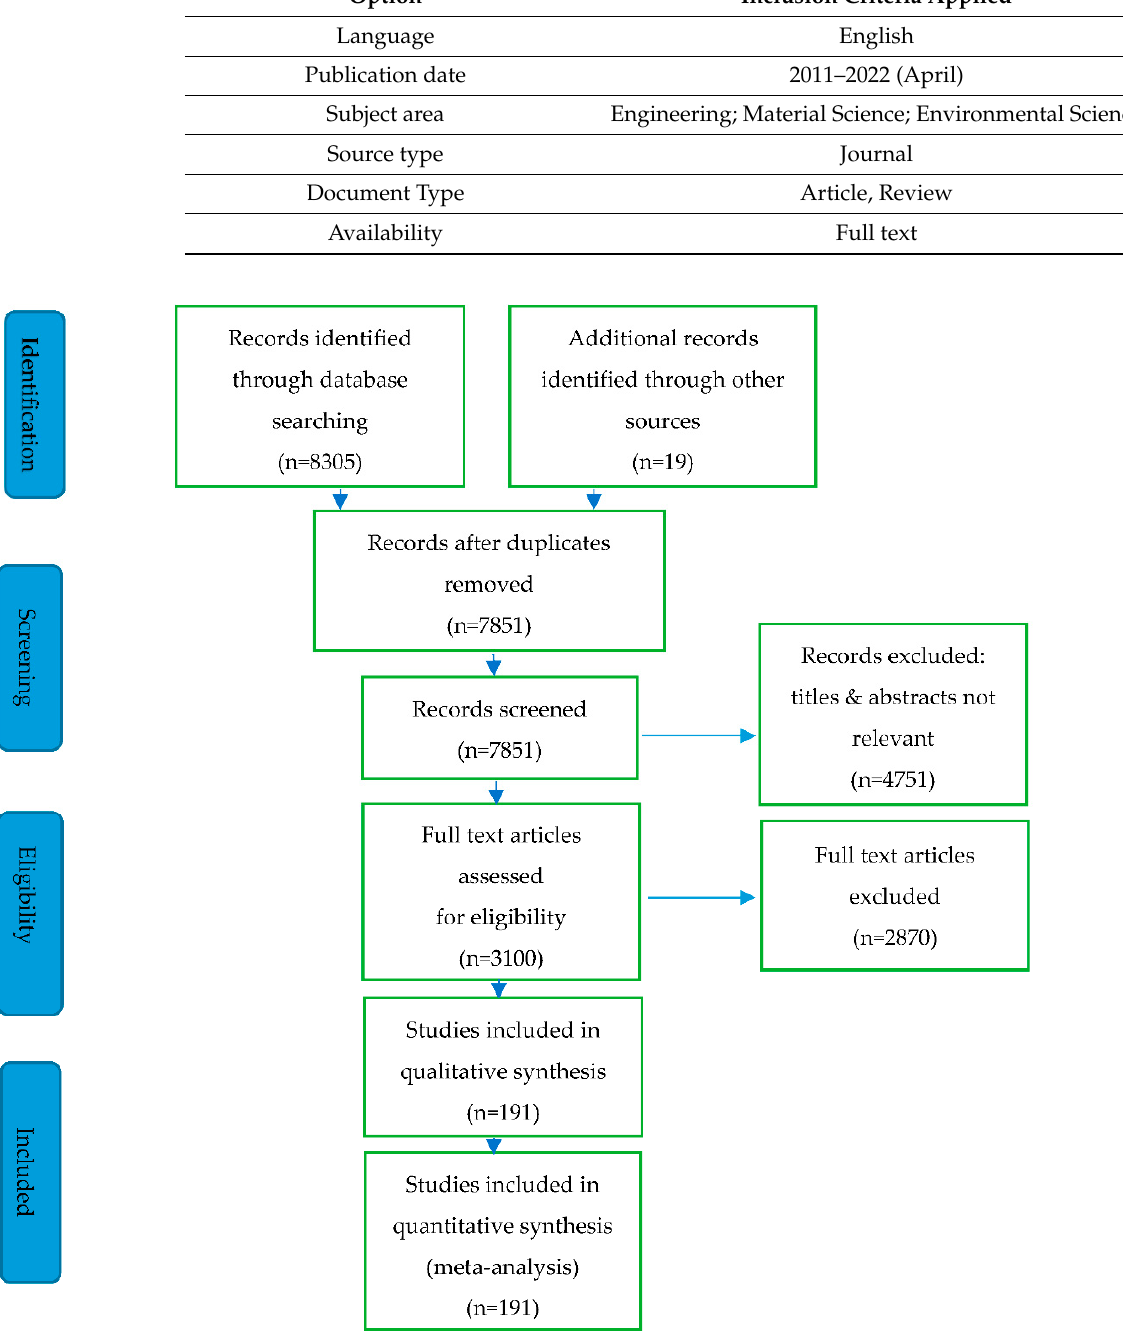
Table 1. Inclusion criteria applied during data retrieval from Scopus as of 25 April 2022.